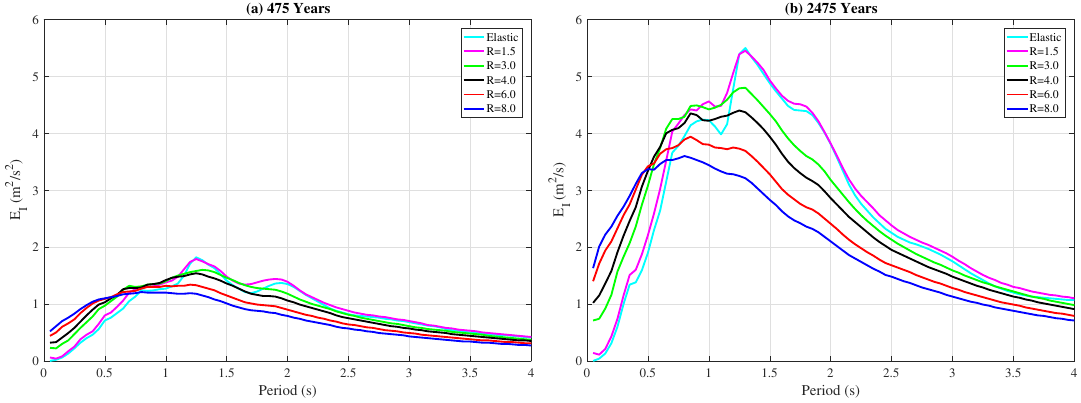
Figure 3. Input energy for SDOF for ( a ) 10/50 and ( b ) 2/50